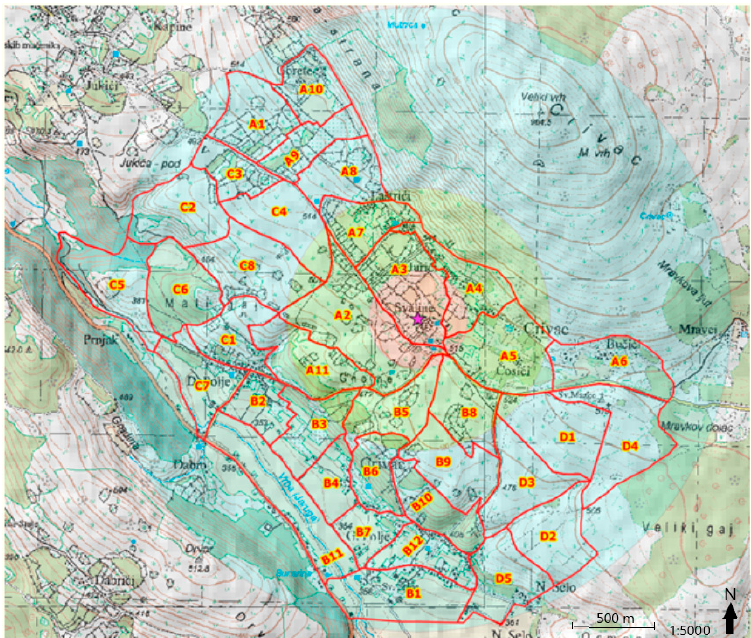
Figure 2. Division of the search area into zones according to the terrain characteristics and the lost person type.